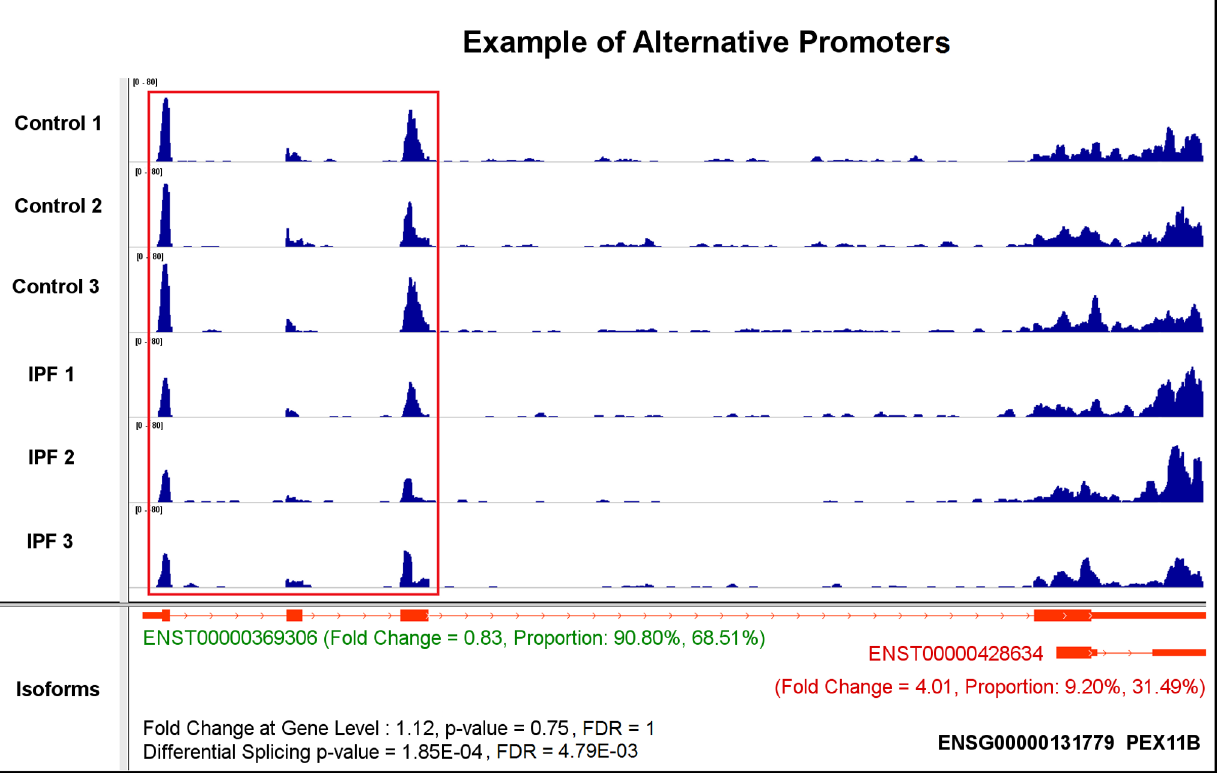
Figure 4. A case study of gene PEX11B as demonstration of the alternative promoters splicing mechanism using the annotated transcripts.